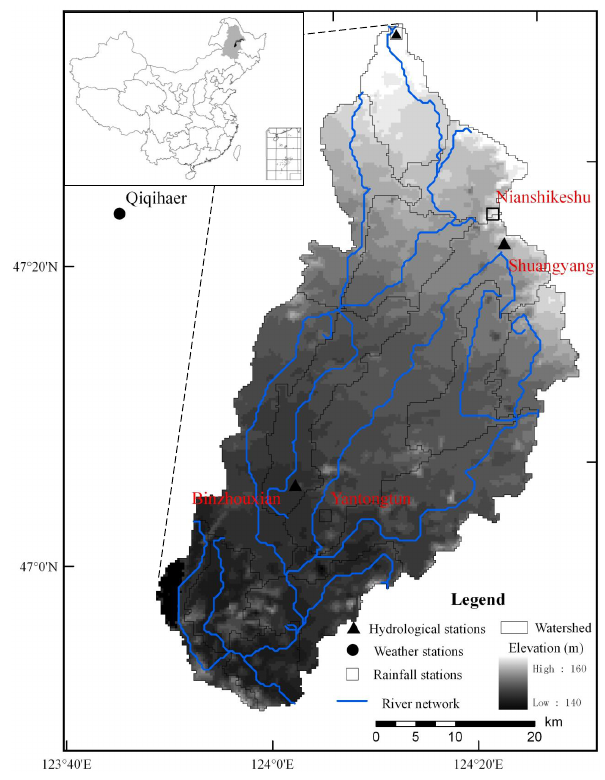
Fig. 1. Location, elevation, hydrological and weather stations, and subbasin division of the Zhalong Wetland in Northeast China.